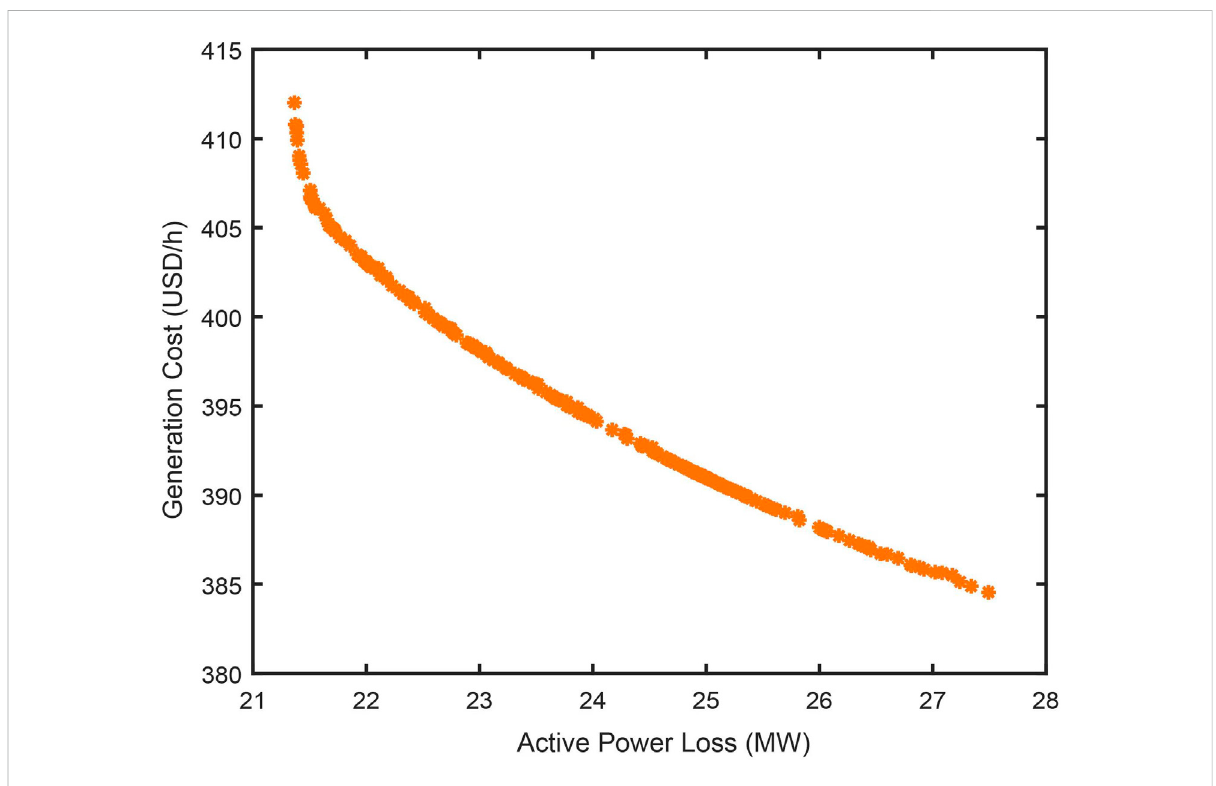
FIGURE 4 Distribution of Pareto optimal sets.